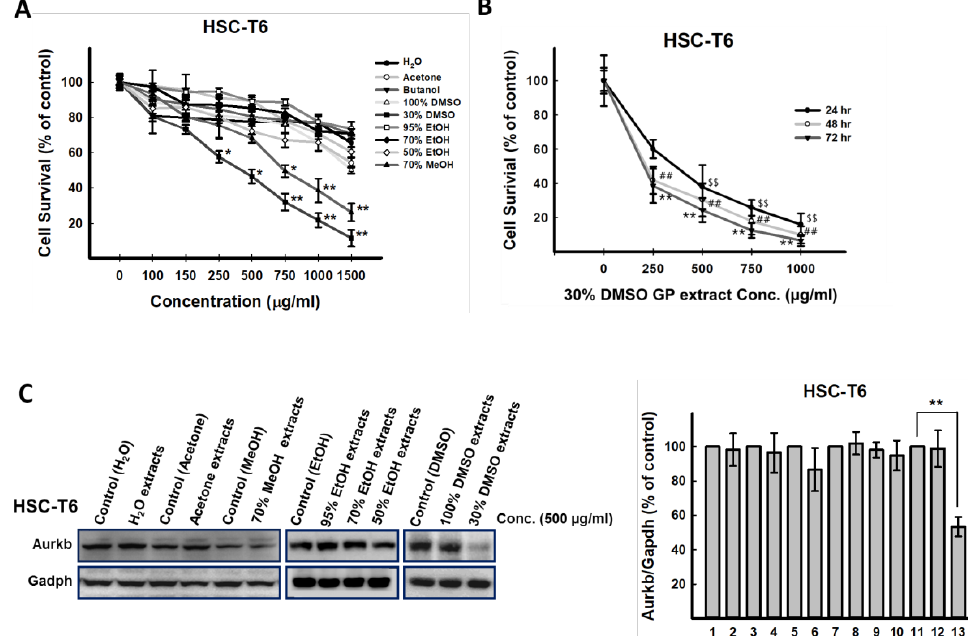
Figure 1. Treatment with the 30% DMSO Graptopetalum paraguayense ( GP) extract, but not